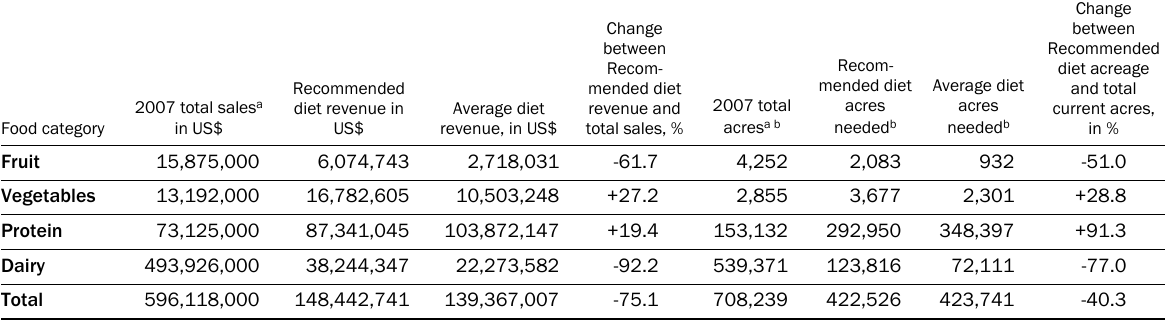
Table 2. Revenue and Acreage Required for Current and Recommended Diets